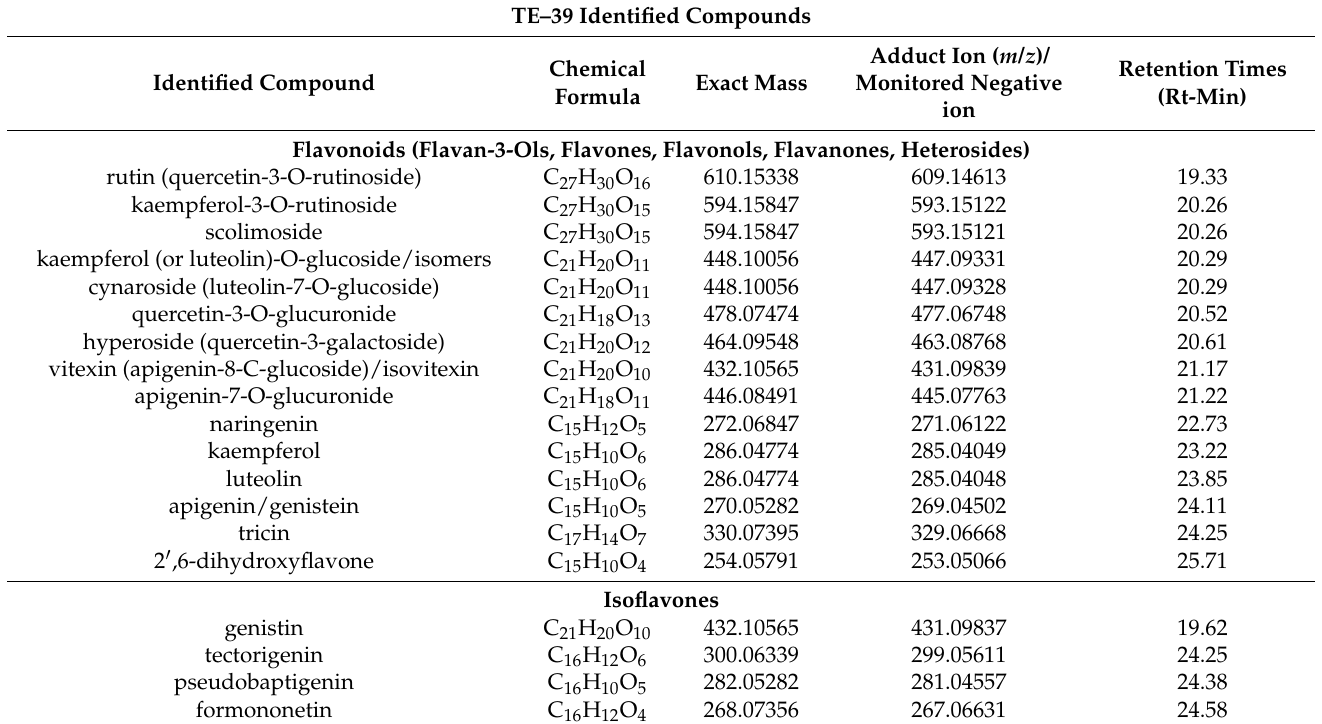
Table 4. Chemical compounds identified in TE by UHPLC–HRMS/MS.